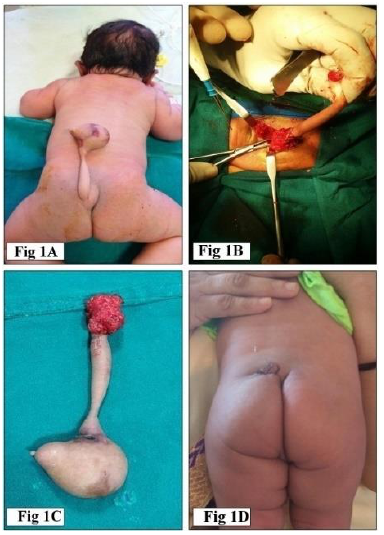
Figure 1: A) Preoperative – Showing baby with a 12cm long tail. B) Intra operative – Elliptical incision taken around the vestigial tail. C) Excised specimen. D) Postoperative – healthy